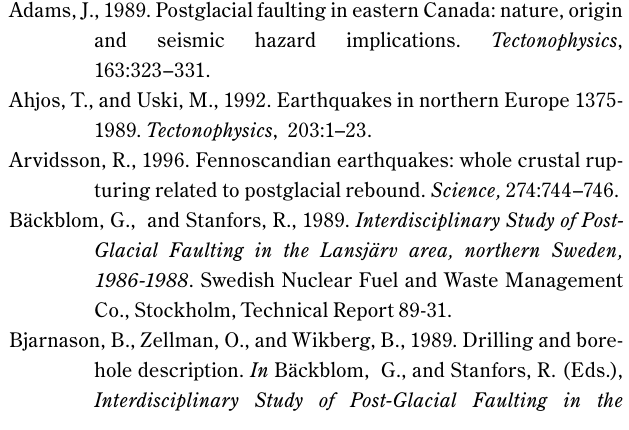
Fig. 2: Björn Lund, Uppsala University, Sweden (large photo); and Roger Lagerbäck, Geological Survey of Sweden (insert